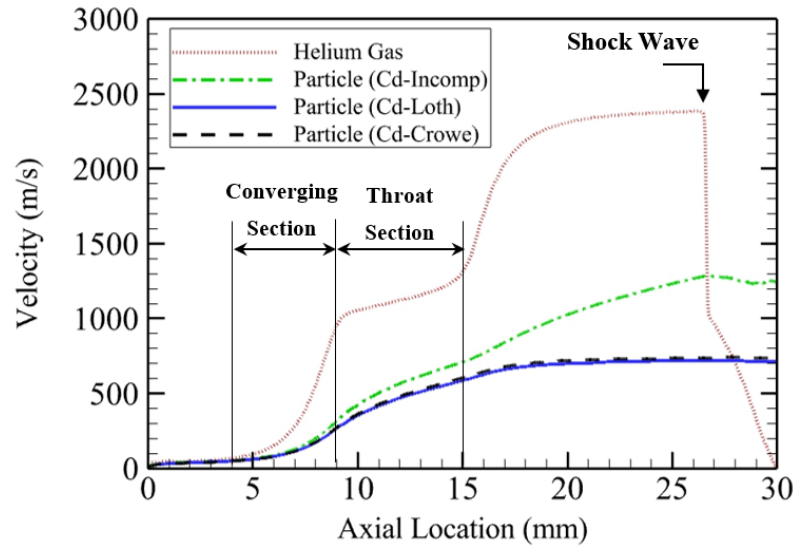
Figure 10. Effect of drag coefficients on centerline particle velocity, 𝑑 𝑝 = 1 μm .